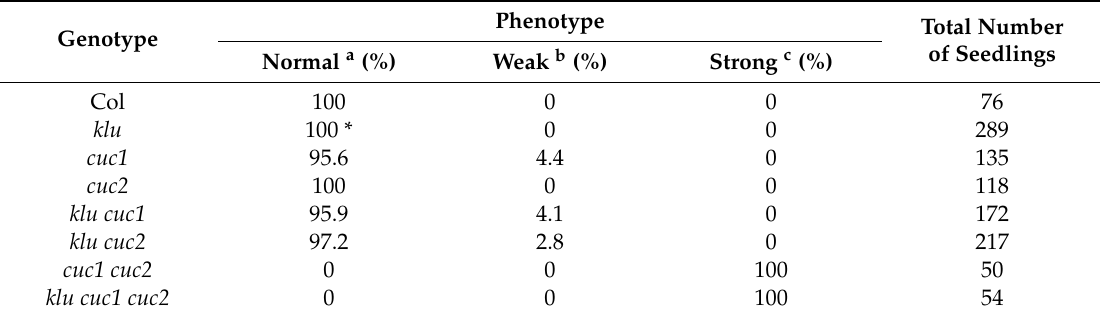
Figure 4. Mutations in KLU cause shoot meristem enlargement and precocious leaf formation. ( A – F ) Shoot apex of wild type ( A , D ), klu ‐ 019348 ( B , E ), and klu ‐ 4 ( C , F ) in cleared seedlings at 3 dag. ( D – F ) are close ‐ up views of ( A – C ), respectively. Optical sections are photographed at a position slightly off ‐ center to reveal the precociously formed third ‐ leaf primordia in the klu mutants (arrows). lp, the first two leaf primordia; m, shoot meristem; st, stipule. ( G ) Shoot meristem width of wild type and two klu mutant alleles at 3 dag. Different letters in box plots indicate statistically significant differences ( p < 0.01, Tukey–Kramer method). Sample size is 34, 28, and 42 for G . ( H – J ) Torpedo ‐ stage embryos of wild type ( H ), klu ‐ 019348 ( I ), and klu ‐ 4 ( J ). Arrowheads indicate the position of the cotyledon boundary region. ( K , L ) CLV3::GUS expression in wild ‐ type ( K ) and klu ‐ 4 ( L ) torpedo ‐ stage embryos. Scale bar = 50 μ m. Table 5. Genetic interactions among klu ‐ 4 , cuc1 ‐ 5 , and cuc2 ‐ 3 .